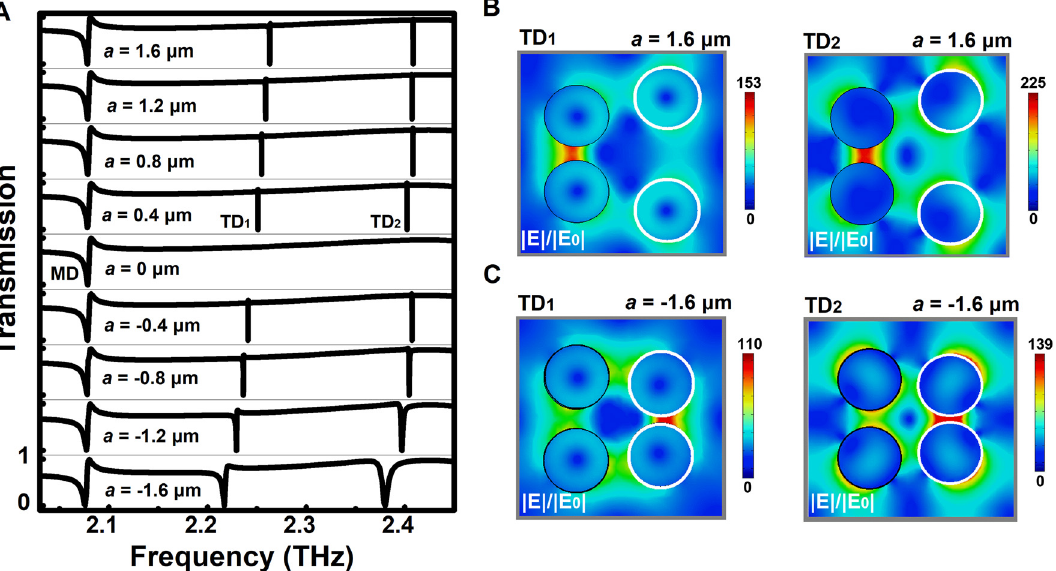
Figure5: (A)Transmissionspectraofall-dielectricmetasurfacewithdifferentasymmetricparameter a .Thecross-sectionalpatternsofelectric fi eld enhancements for TD a = 1.6 μ m and (C) a = − 1.6 μ m in the x – y plane with z -axis corresponding to the half-height 1 and TD 2 at (B) of the cylinder, the white solid circles represent the perturbed